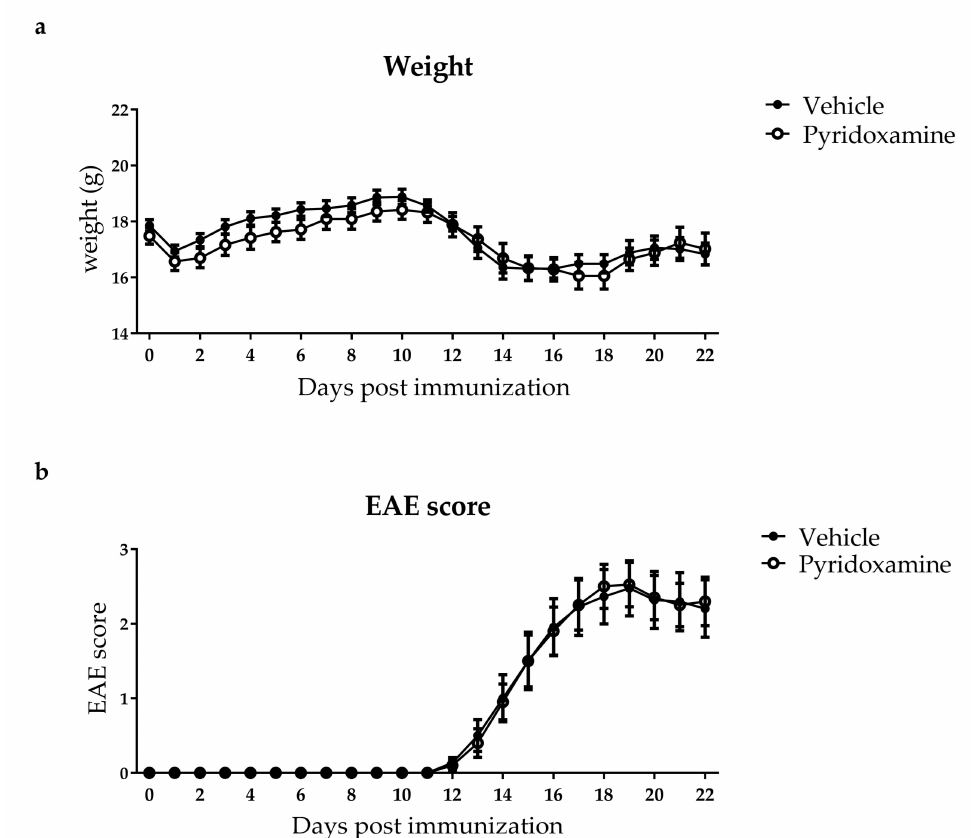
Figure 1. 10 g/L Pyridoxamine does not affect EAE disease outcome. Mice were immunized with myelin oligodendrocyte glycoprotein (MOG) to induce EAE and treated with either vehicle or 10 g/L pyridoxamine. Vehicle ( n = 11) and 10 g/L pyridoxamine ( n = 10) treated mice were weighed ( a ) and scored ( b ) daily for 22 days after EAE induction. Closed circles ( ) represent vehicle treated mice and open circles ( ) represent 10 g/L pyridoxamine treated mice. Data is presented as mean ± SEM and (cid:35) analyzed using two-way analysis of variance (ANOVA) with Sidak’s multiple comparisons